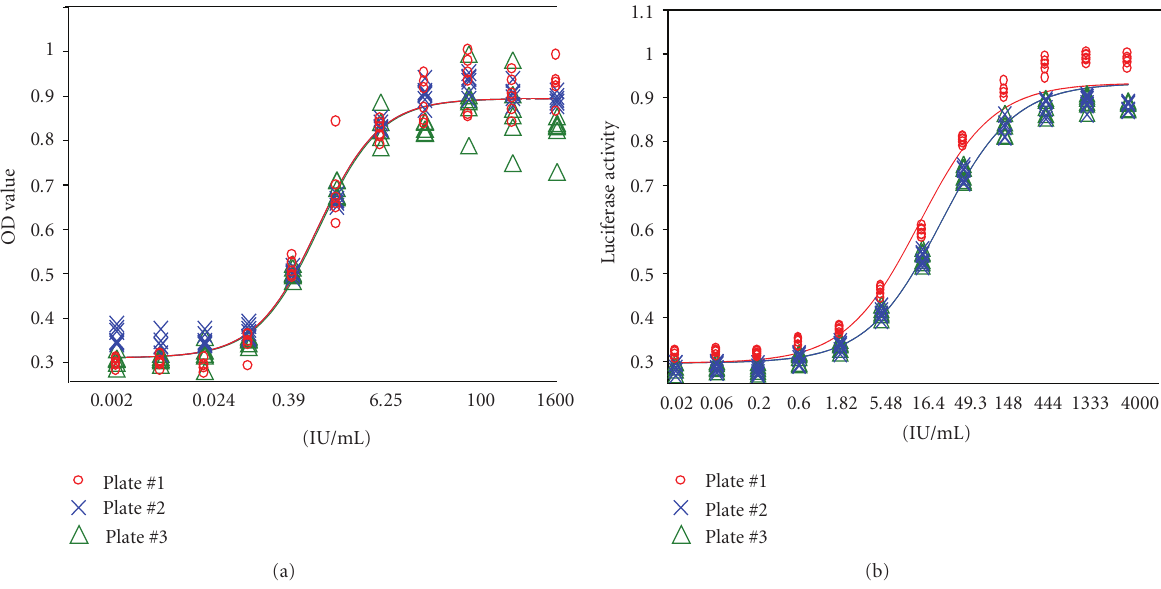
Figure 8: Comparison between AVA and RGA. Panel (a) represents dose response curve from the AVA for the potency determination of IFN- β 1b. Panel (b) represents dose response curve from the RGA for the potency determination of IFN- β 1b. For both methods, each dose of the sample was analyzed in six replicates on three di ff erent plates. Data shown here represents one of several repeated